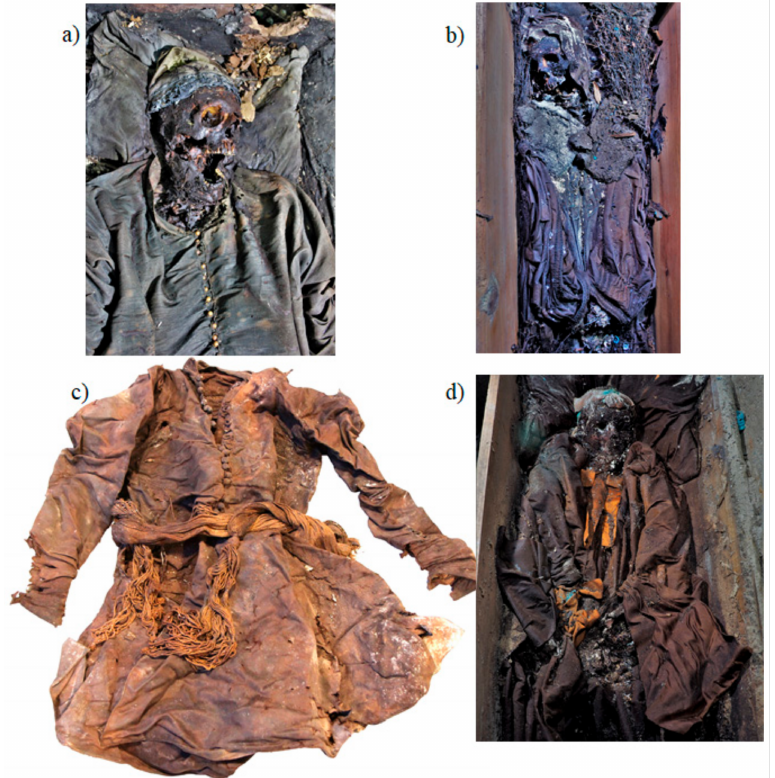
Figure 1. Images of the burial robes found in the crypts: ( a ) zhupan, male national costume C5/b14, ( b ) woman’s dress C5/b11, ( c ) zhupan C8/b6, and ( d ) monk habit C9/b7; photo by M.